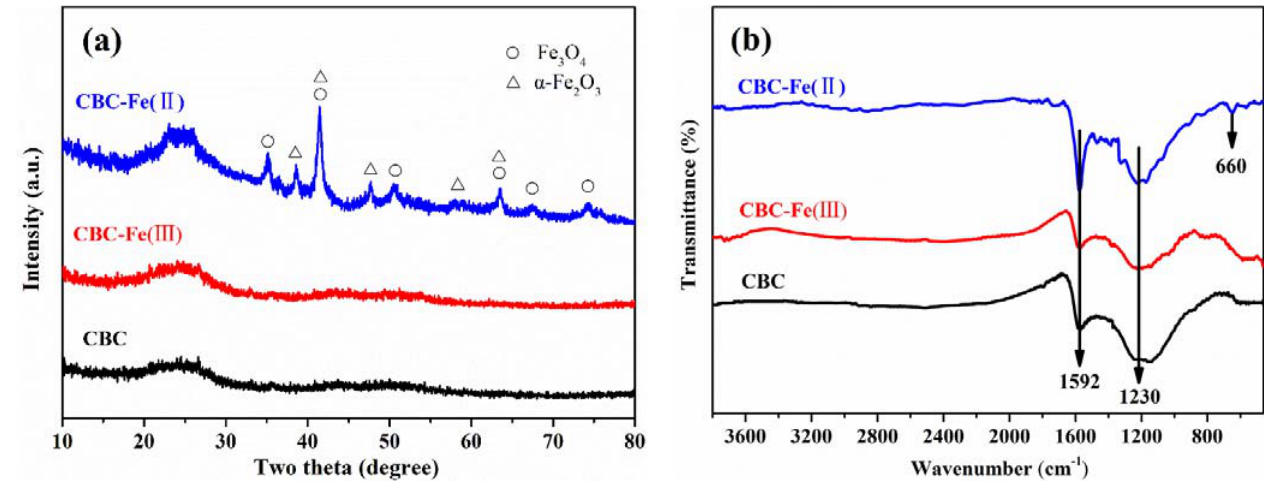
Figure 1. ( a ) XRD patterns and ( b ) FTIR spectrum of CBC, CBC ‐ Fe(III) and CBC ‐ Fe(II). The functional groups of CBC, CBC ‐ Fe(III) and CBC ‐ Fe(II) were determined by FTIR spectra and are shown in Figure 1b. For the three samples, the peaks at 1592 cm − 1 were attributed to the aromatic C=C groups stretching variations [27,40]. The peaks at 1230 cm − 1